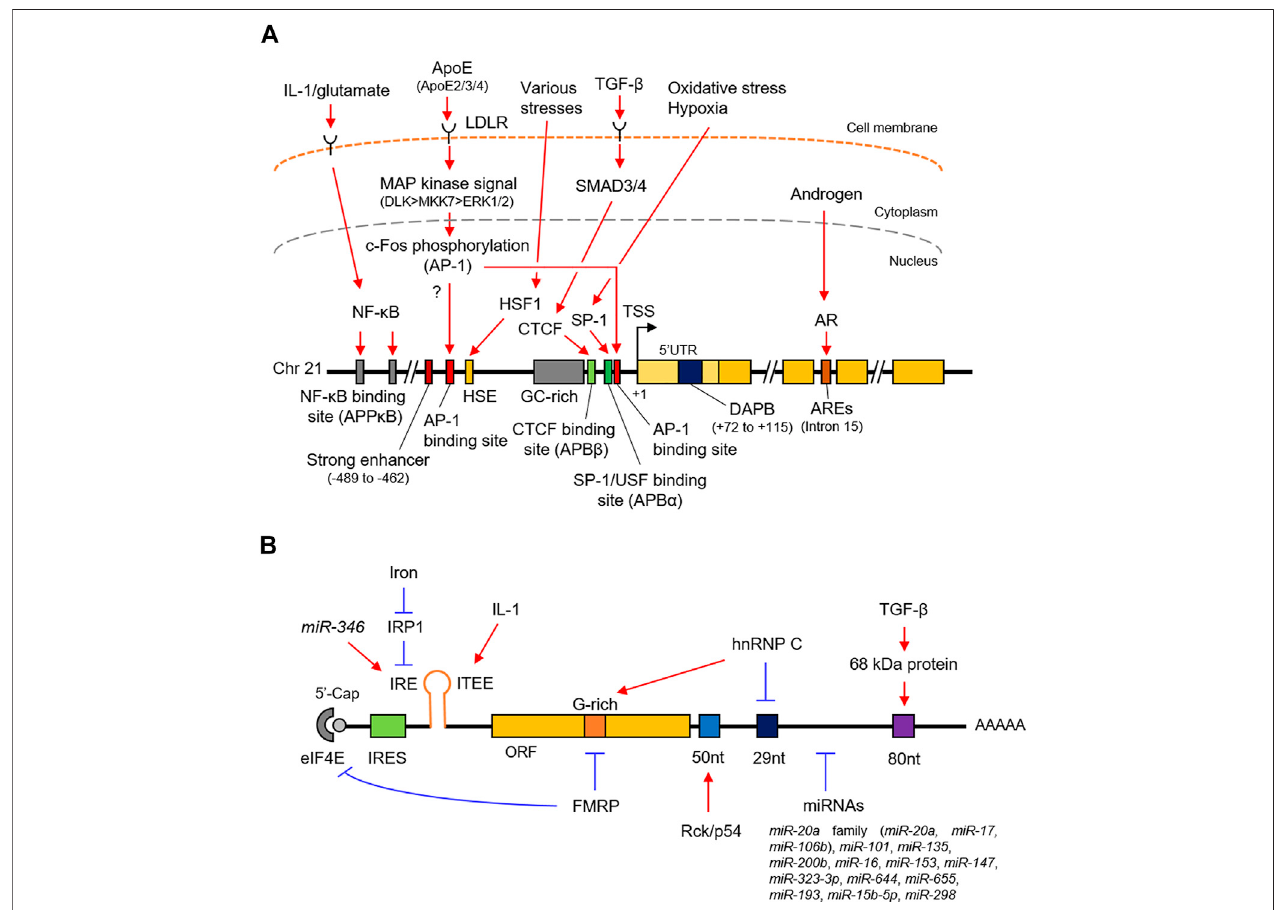
FIGURE 1 | Schematic representation of the transcriptional and post-transcriptional regulation of APP . (A) . The promoter structure and regulating factors for the APP transcription. (B) . cis- regulatory elements and trans- acting factors for the post-transcriptional regulation. APP , amyloid- β precursor protein; SP-1, putative SP-1 binding site; AP-1, putative AP-1 binding site; HSP, heat shock element; DAPB, DNase I protected domain; ARE, androgen response element; AR, androgen receptor. IRES, internal ribosome entry site; IRE, iron responsive element; ITEE, interleukin-1 translation enhancer element; IRP1, iron response protein 1; 52 nt, 52 nt element; 29 nt, 29 nt element; 80 nt, 80 nt